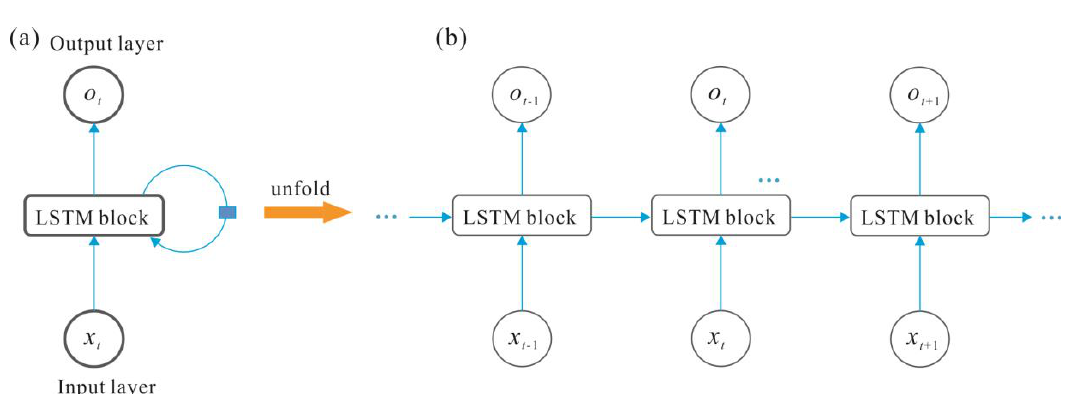
Figure 2. Recurrent neural network ( a ) and folded computational diagram, where the blue square indicates a delay of one time step ( b ).